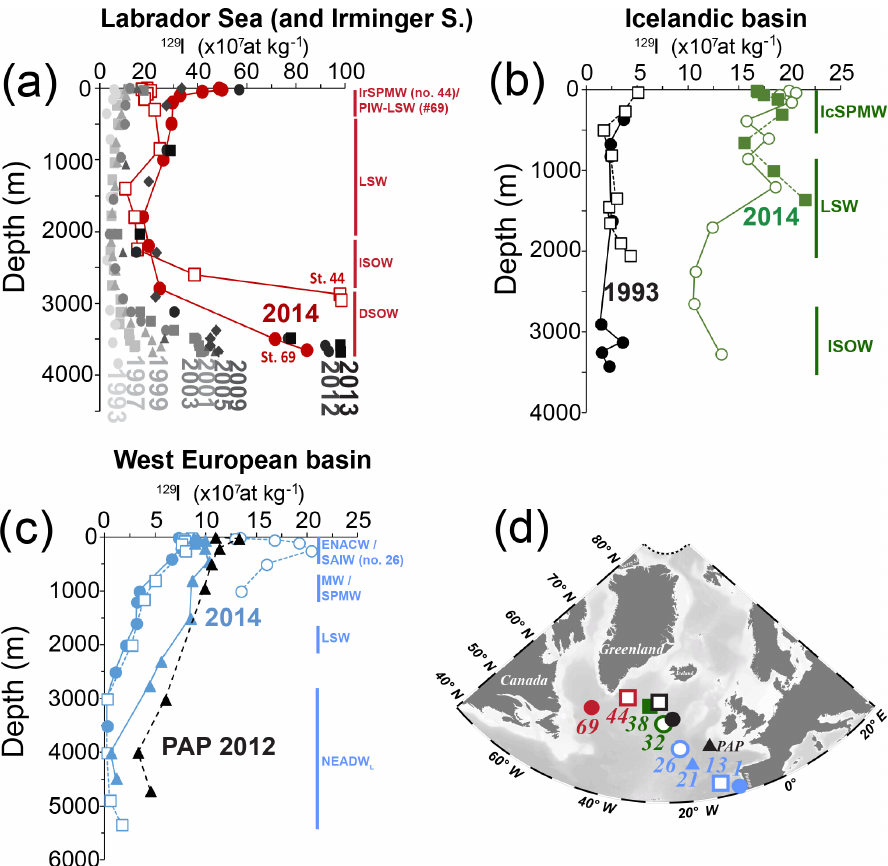
Figure 5. Vertical profiles of 129 I concentrations at locations shown in (d) of selected GEOVIDE stations and of those reported in nearby locations by earlier studies. (a) 129 L in the Labrador and Irminger seas, red profiles represent data from this work (2014). Data from 1993 were reported south-west of the GEOVIDE station 69 by Edmonds et al. (2001). Data from 1997 to 2013 were reported at station 17 of the AR7W line: for 1997, 1999 and 2001 by Smith et al. (2005); for 2003, 2005 and 2009 by Orre et al. (2010); and for 2012 and 2013 by Smith et al. (2016). (b) In the Icelandic Basin, green profiles show data from GEOVIDE stations 32 and 38 in 2014, while black profiles represent data from 1993 reported by Edmonds et al. (2001). (c) In the West European Basin, blue profiles represent data from GEOVIDE stations 1 to 26, while data from 2012 in the Porcupine Abyssal Plain (PAP) were reported by Vivo-Vilches et al. (2018). Water masses found during GEOVIDE cruise have been summarised and represented in same colour as the 129 I concentration profiles. Acronyms are defined in the